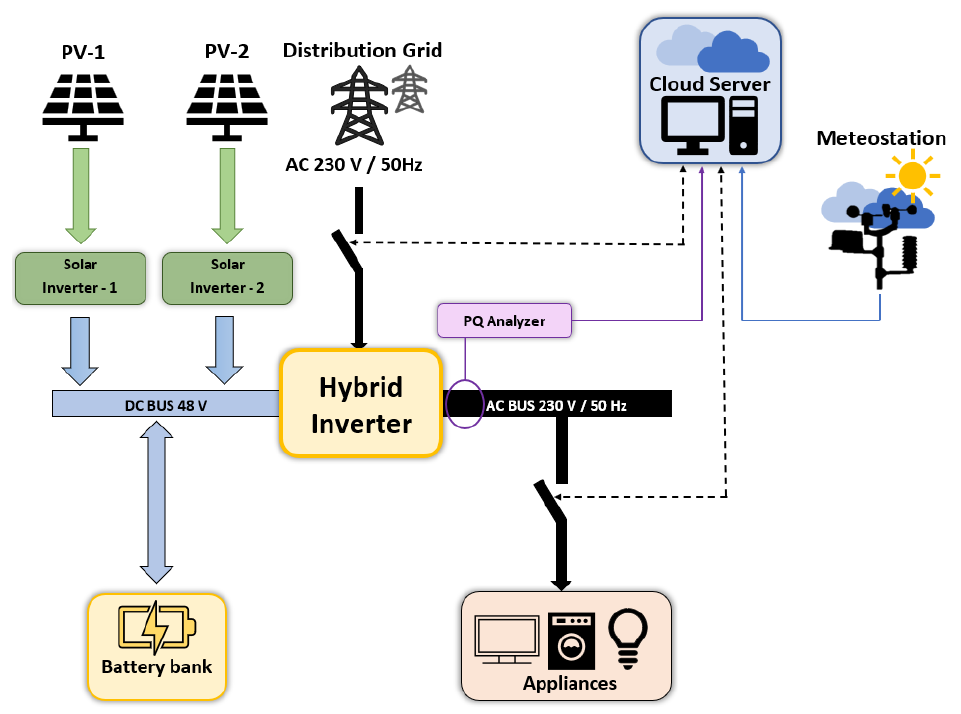
Figure 1. Schematic of off-grid system.